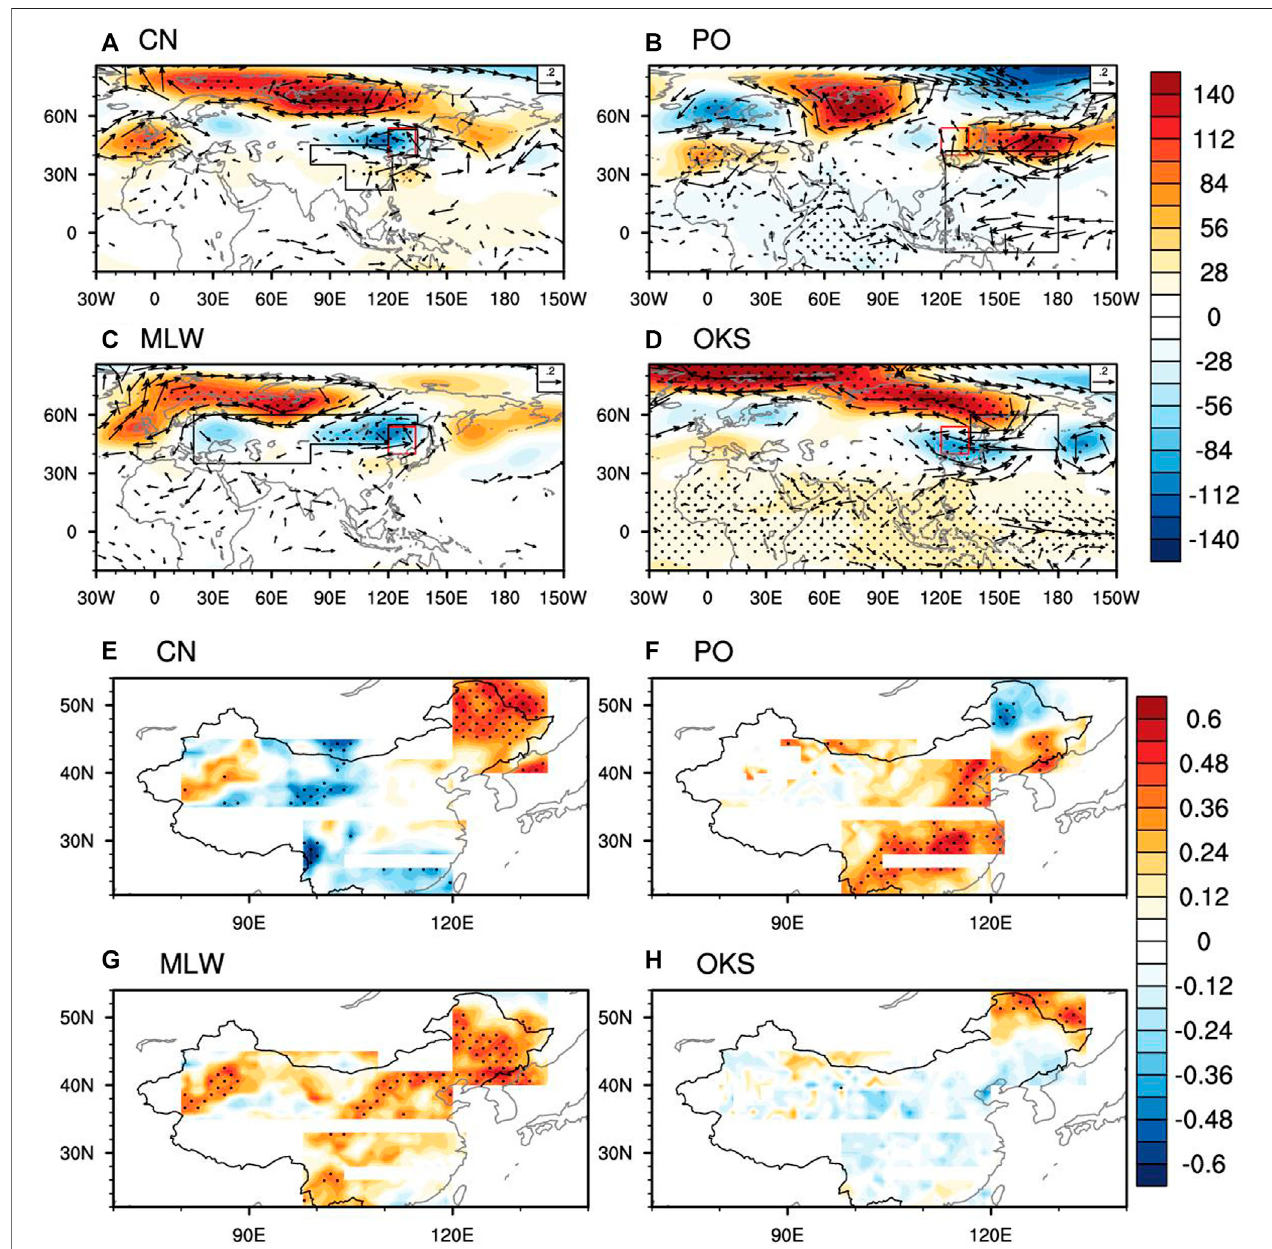
FIGURE 7 | As in Figure 5 but for NE. Panels (A – D) show circulation anomalies regressed against the CN, PO, MLW and OKS moisture sources. Panels (E – H) show the CN, MLW and OKS source precipitation anomalies correlated with the NE vortex index, and the PO source with the PJ